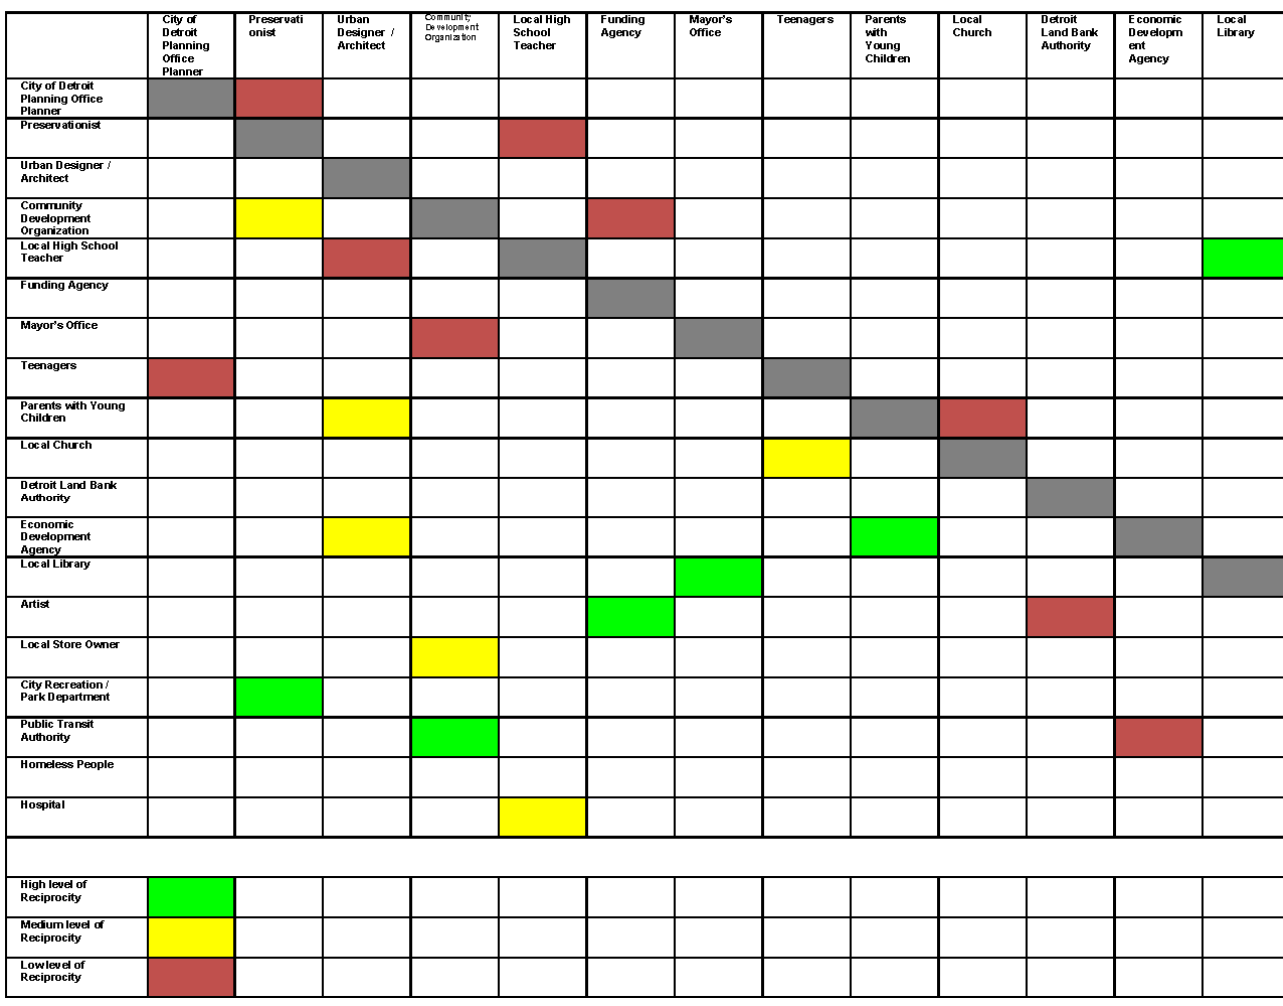
Figure 11. An example of reciprocity (a workshop team used a chart like this to strategize how to implement the reciprocity model). Note: This chart is used for role-playing by a team of two people; green stands for a high level of reciprocity (suggesting that both members in a given team agree 80 to 100 percent that each member plays their respective role well in contributing to a given project in its workshop(s); yellow stands for a medium level, i.e., 60 percent; brown stands for a low level, i.e., 20 to 40 percent; and gray signifies “not applicable” (N/A).